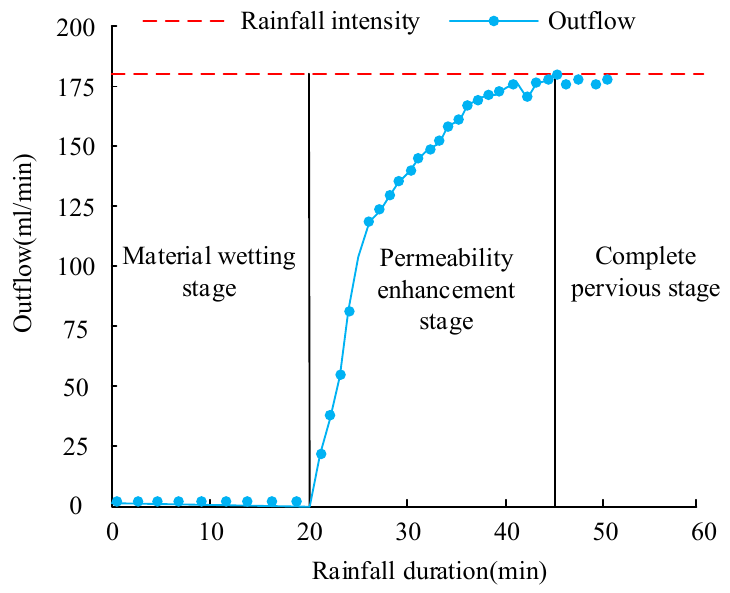
Figure 2. Schematic diagram of permeability curve.